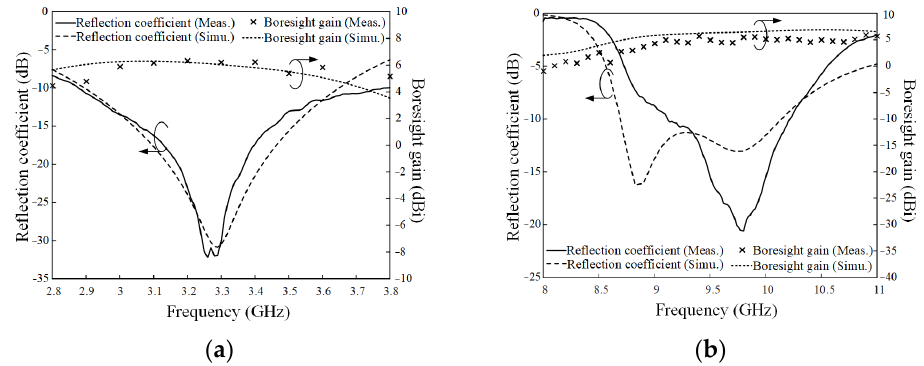
Figure 4. The bore-sight gains and reflection co-efficients of the proposed antenna: ( a ) S-band; ( b ) central X-band.